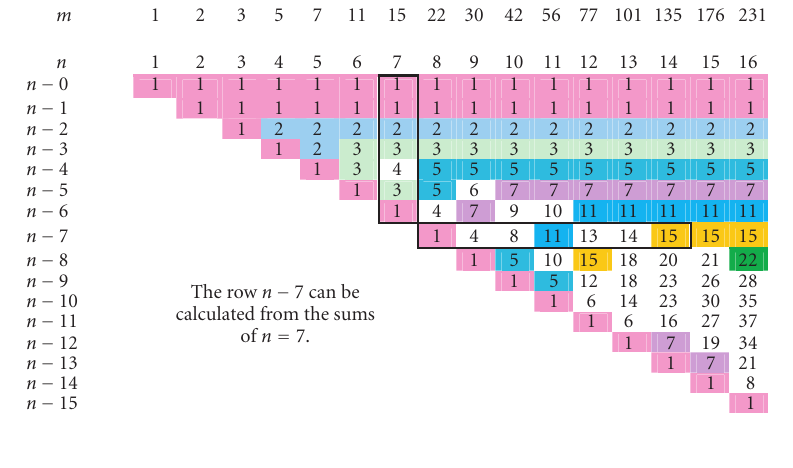
Table 4.1. Iterative calculations for the number m of Young diagrams for a given number n of boxes.